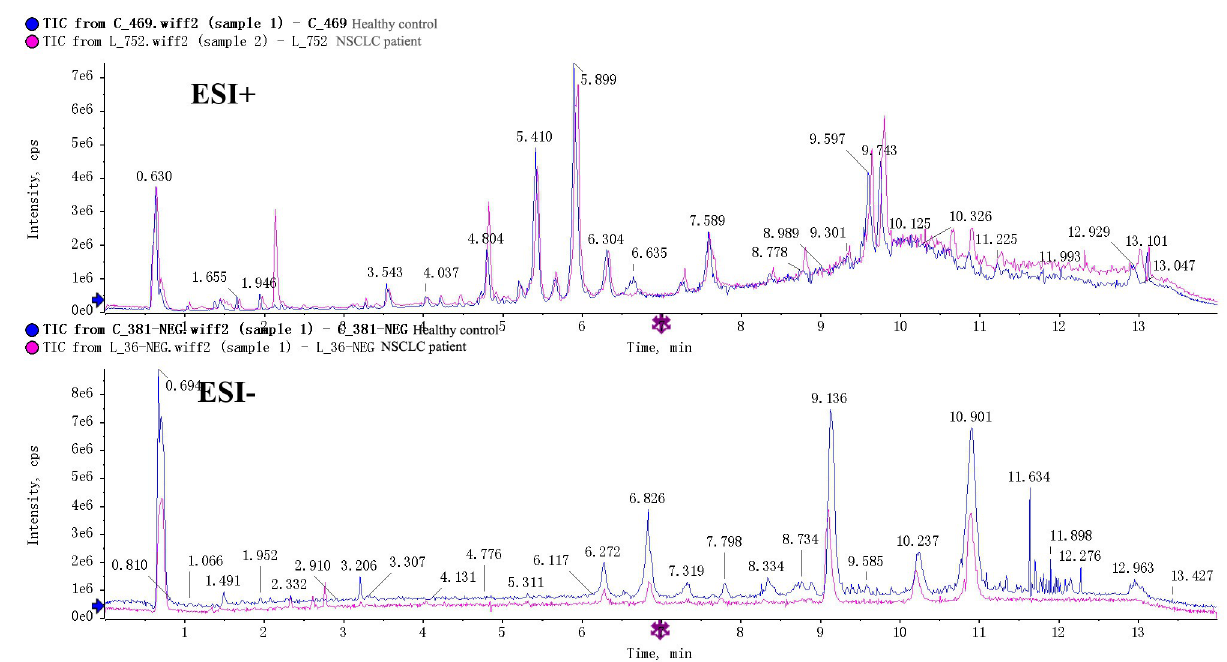
Fig 2. Representative TIC chromatograms of serum from NSCLC patient (red) and healthy people (blue) in ESI+ or ESI- mode.